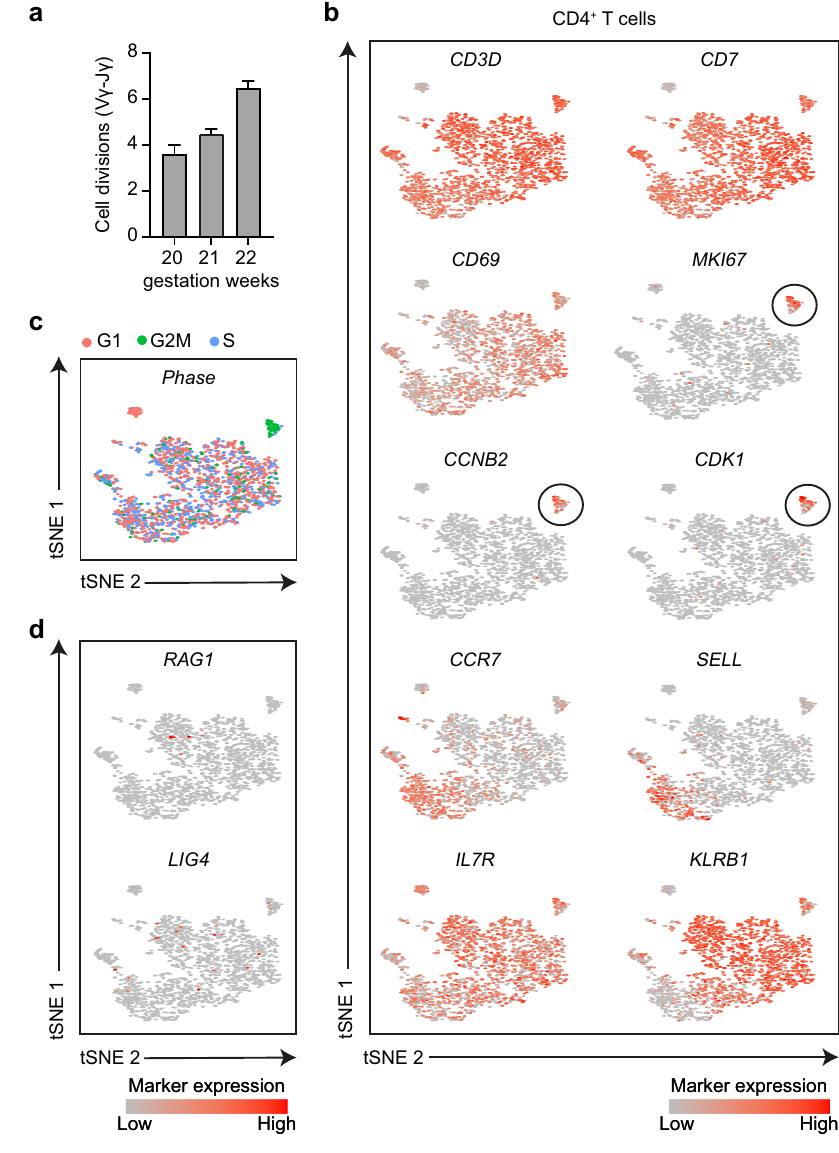
Fig. 4 | T cell receptor excisions circle (TREC) and single cell RNA-seq analysis con fi rms peripheral expansion of intestinal T cells. a Proliferative history in human fetal intestinal samples ( n =3). Error bars indicate mean±SD. b – d t-SNE embedding showing 1804 CD4 + T cells from a human fetal intestine analyzed by